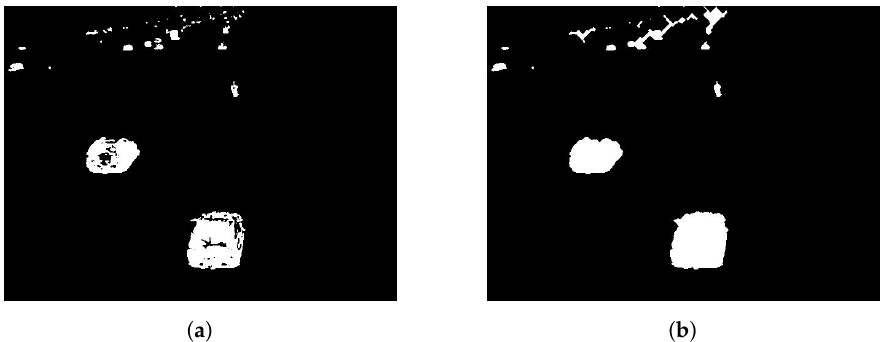
Figure 9. Final detection. ( a ) Union of four detection results ( I binary union